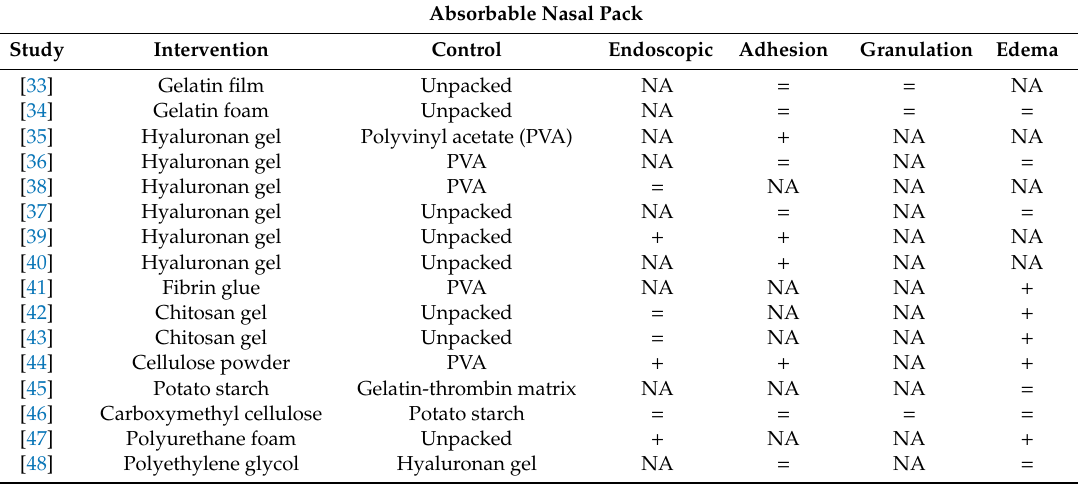
Table 1. E ff ect of absorbable nasal pack on nasal wound healing